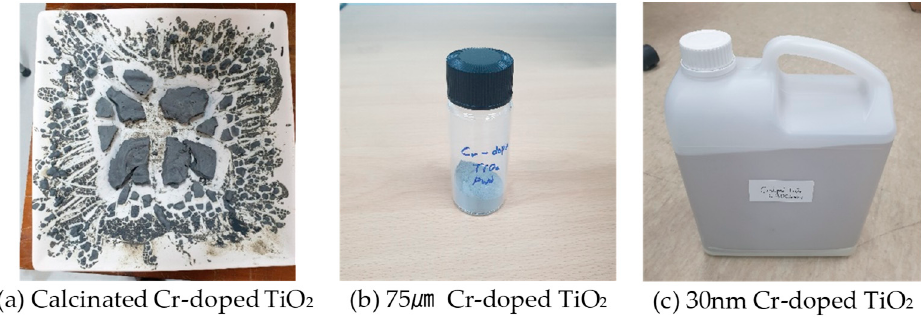
Figure 9. Results of calcination and milling of TiO 2.